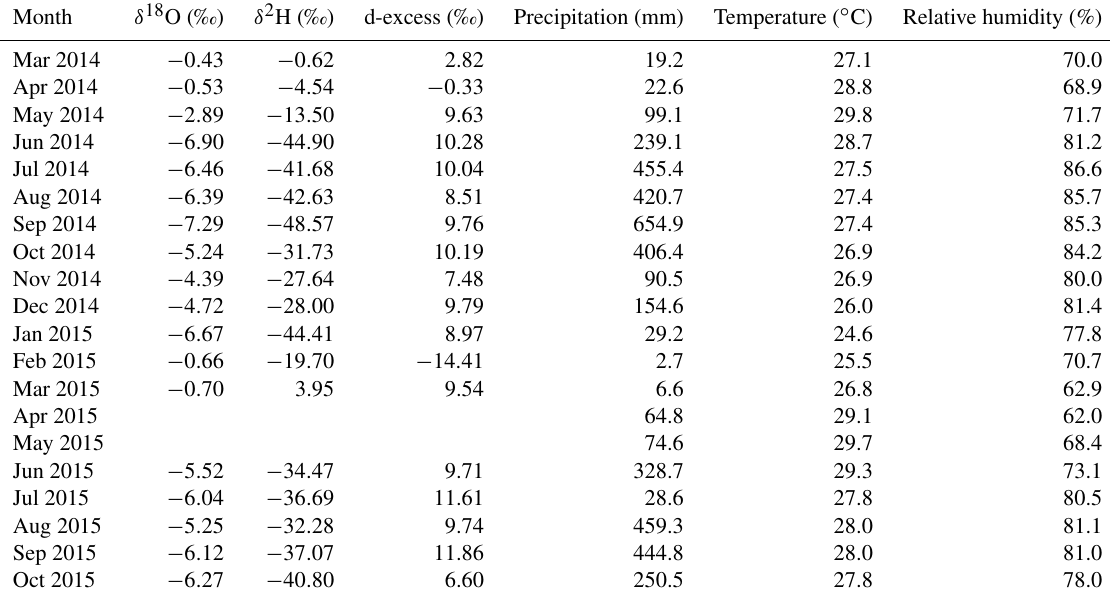
Table 2. Monthly average values of the 19-month time series of δ 18 O, δ 2 H, d-excess, and meteorological parameters (temperature and relative humidity). Precipitation values are reported as monthly